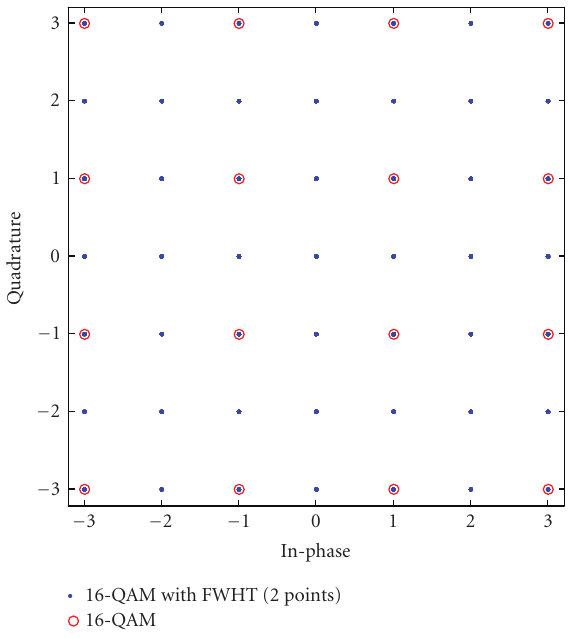
Figure 15: Constellation diagram of OFDM signal.